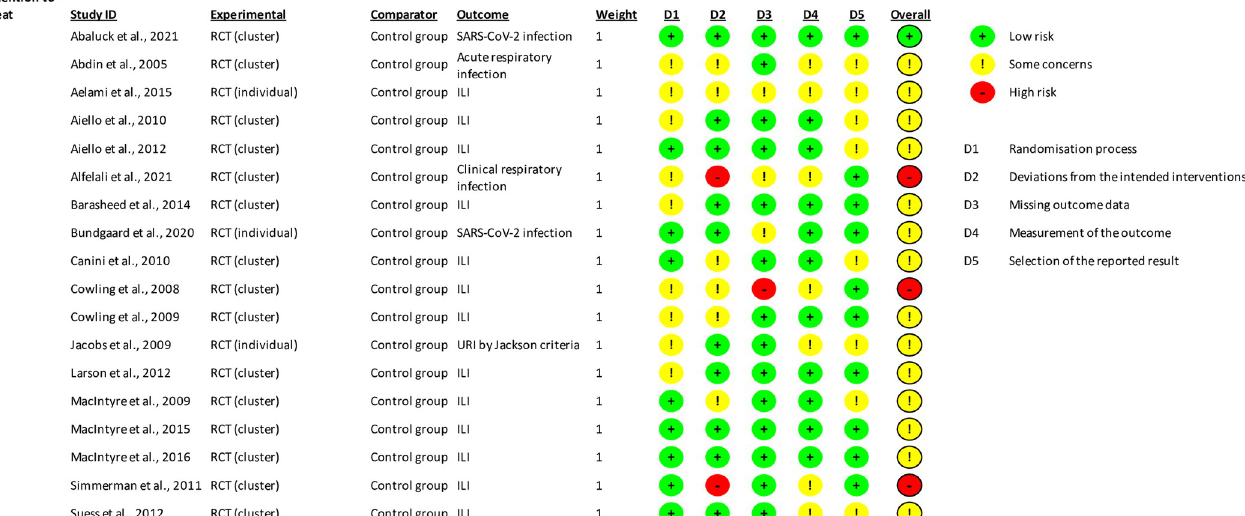
PLOS ONE | https://doi.org/10.1371/journal.pone.0271517 December1,